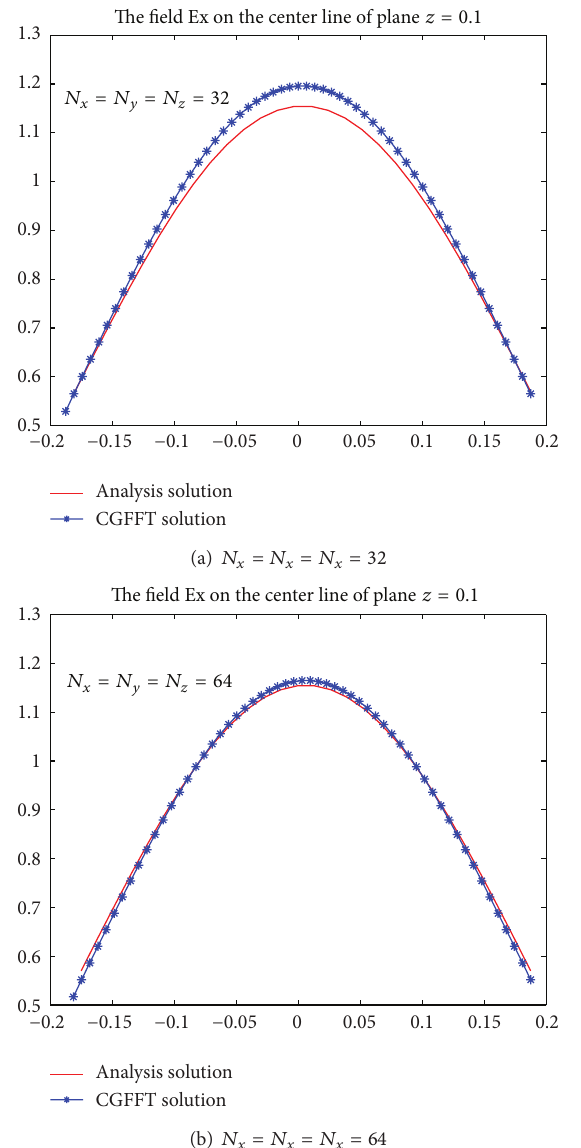
Figure 1: Electric field distribution on the center line of plane 𝑧 = 0.1